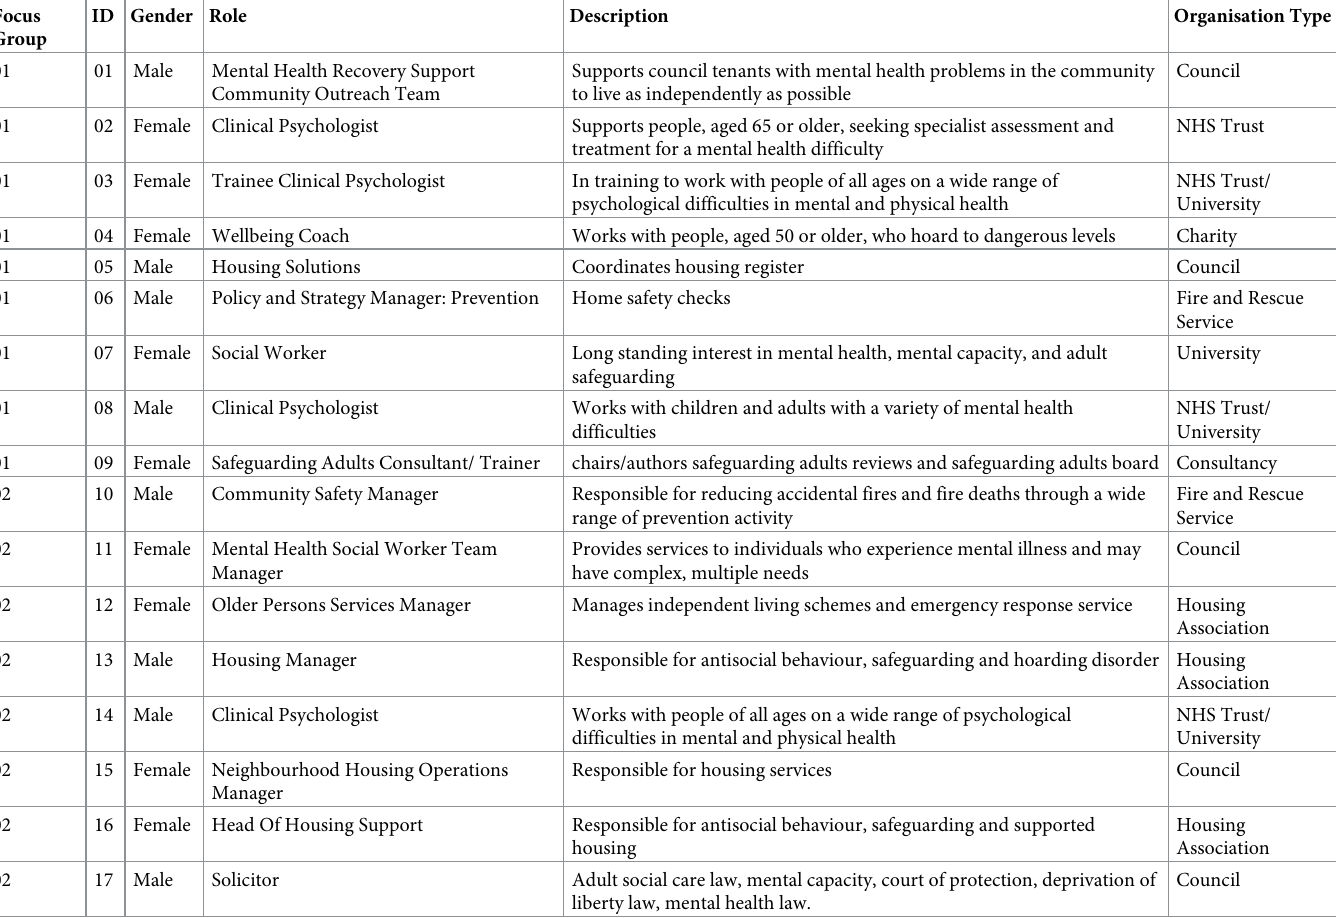
Table 1. Characteristics of focus group